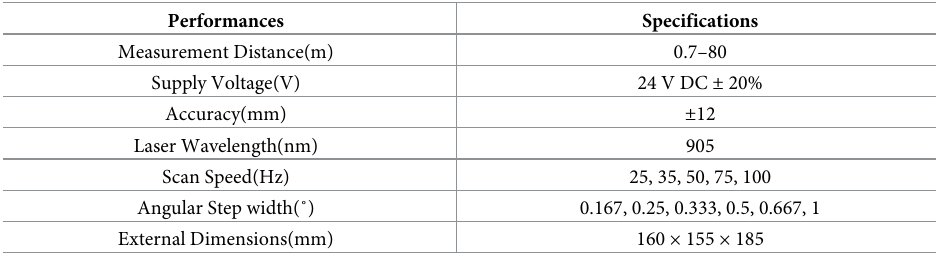
Table 1. Specifications of the SICK